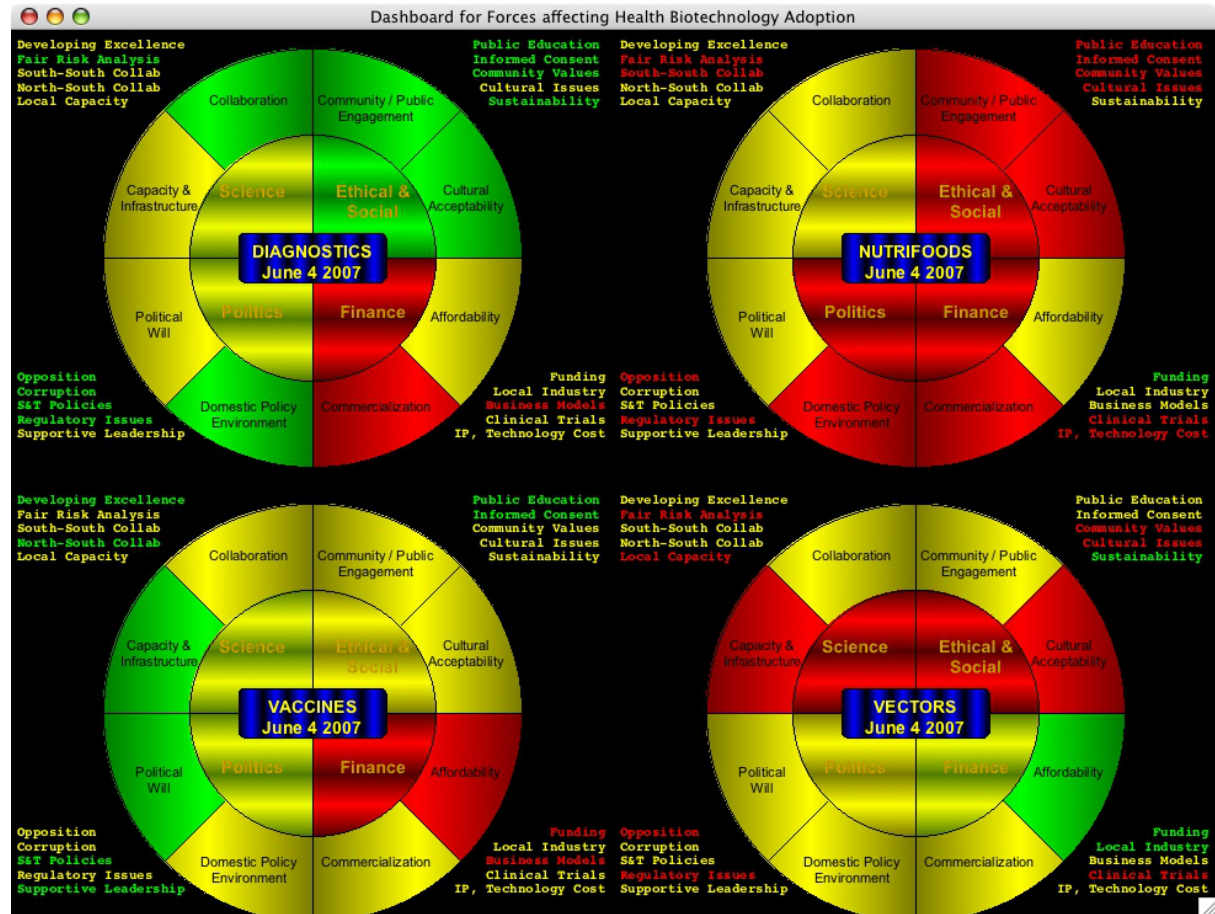
Figure 3. Simulated dashboard set for four health technology